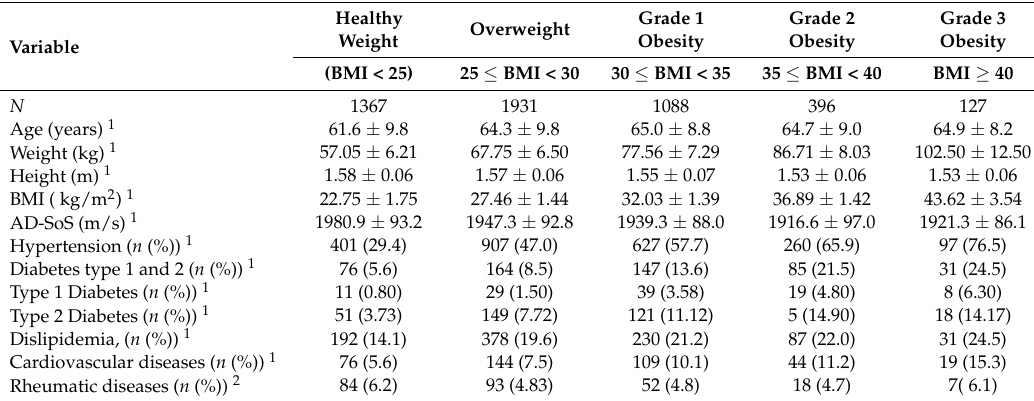
Table 3. Baseline characteristics of study population stratified by classes of BMI.